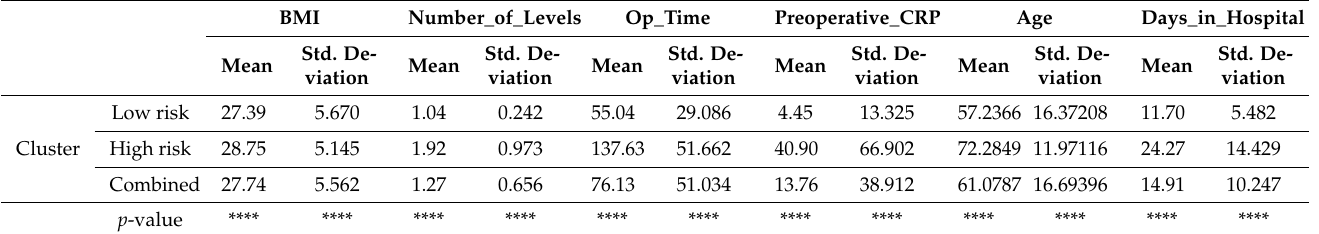
The second cluster analysis was done with the hospital length of stay (LOS) as a binary class type utilizing the 75% percentile as the cut-off point. The cluster analysis resulted in two clusters (26.8% in cluster 1 and 73.2% in cluster 2) (Figure 2). The data distribution showed that all cluster variables (BMI, number of levels, age, preoperative CRP) were significantly higher for cluster number 1 than cluster number 2 ( p < 0.0001 for all comparisons) (Table 2). Further, the distribution of LOS class was significantly different between clusters 1 and 2, with all prolonged cases being in cluster 1 and normal cases being in cluster 2 ( p < 0.0001).